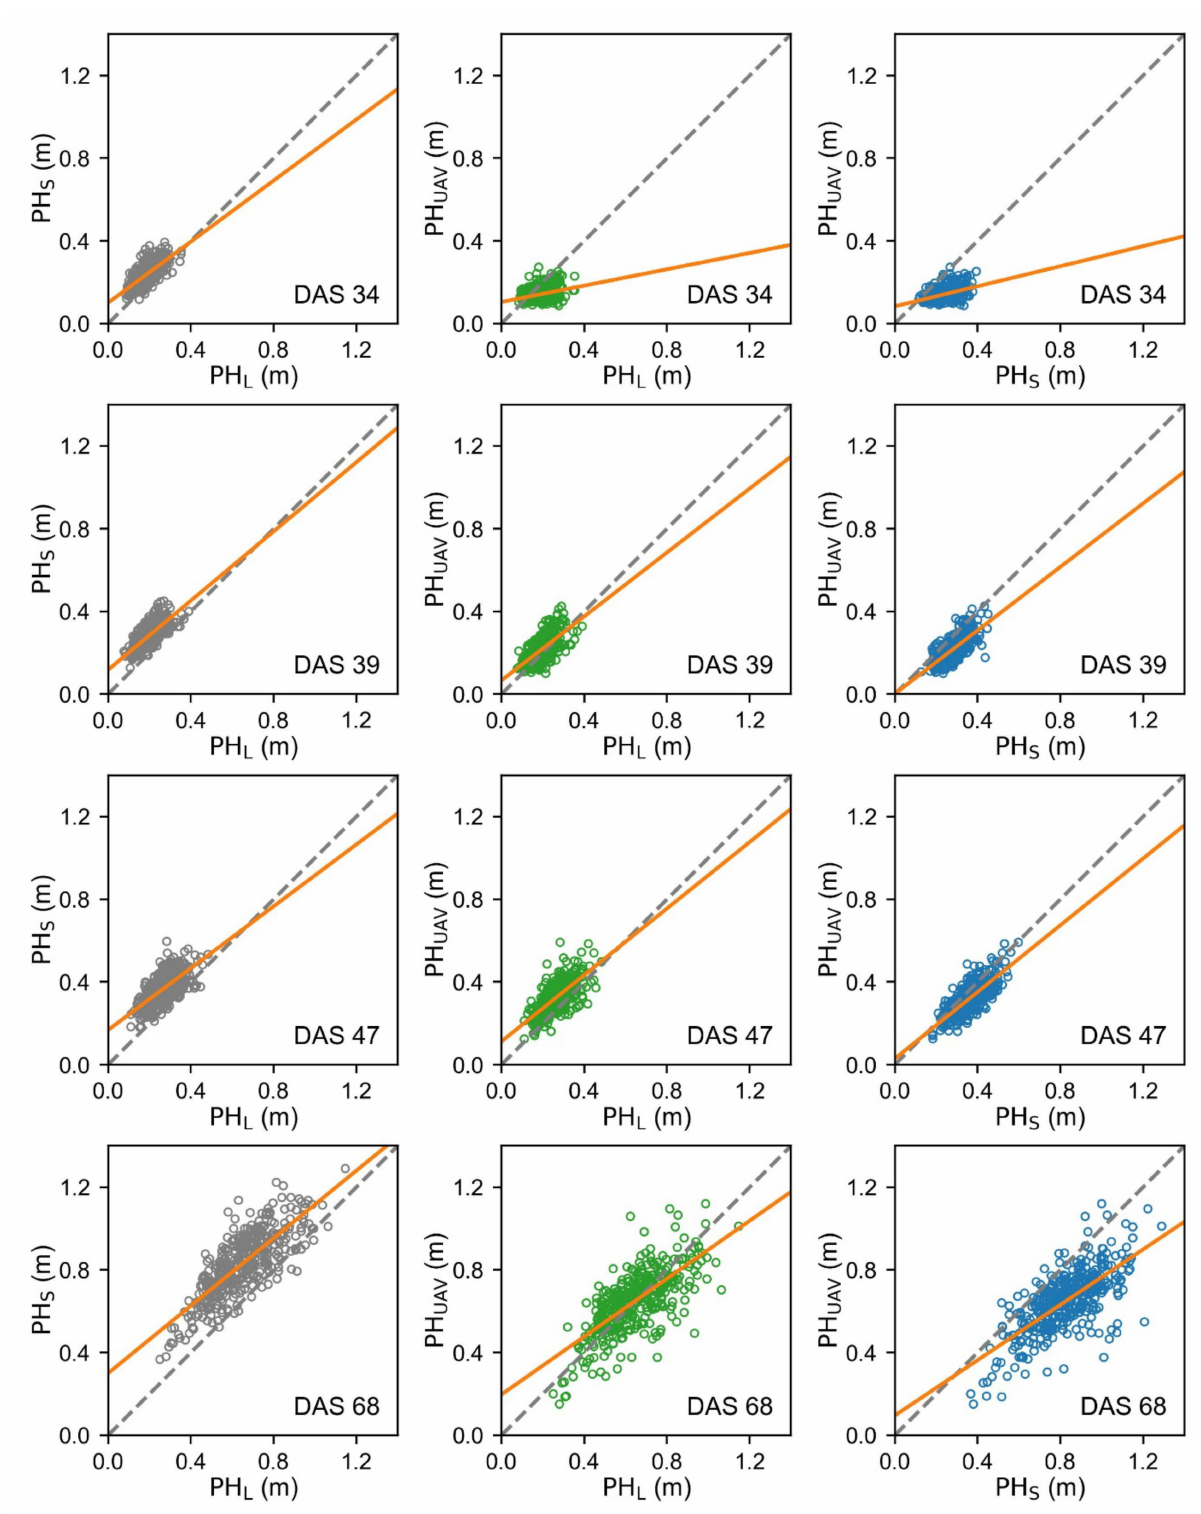
Figure 5. Manually measured plant height of the highest leaf (PH L ) and the highest straightened leaf (PH S ) compared to one another (grey) and UAV-based plant height estimation (PH UAV ) compared to PH L (green) and to PH S (blue). The linear regression line is shown in orange and its equation is specified in Table 2; DAS: days after